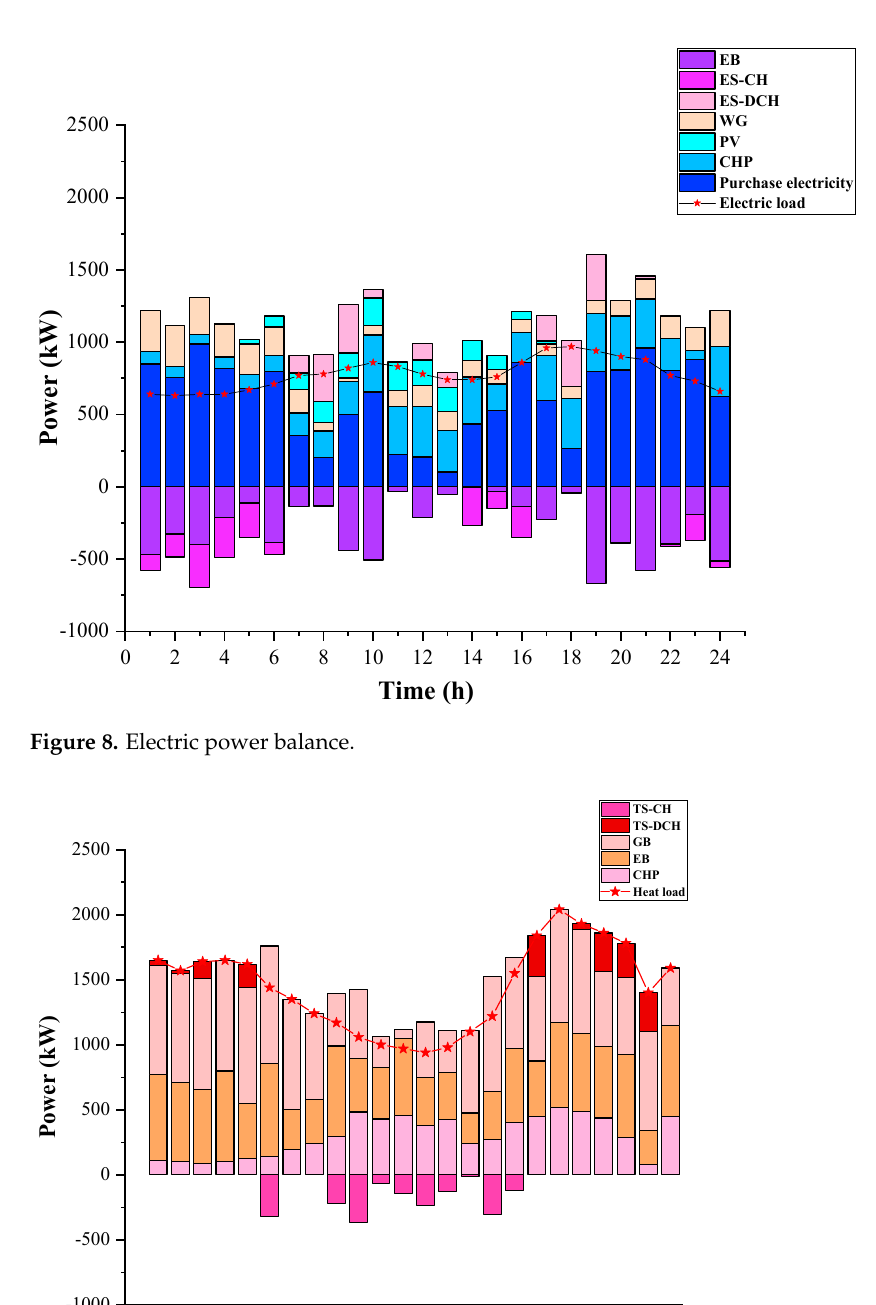
18 of 24 Table 4. Optimization results with and without correlation. Equipment